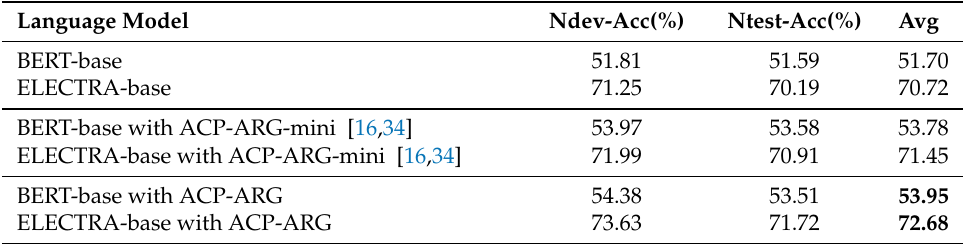
Table 4. Commonsense QA results on different language encoder types.